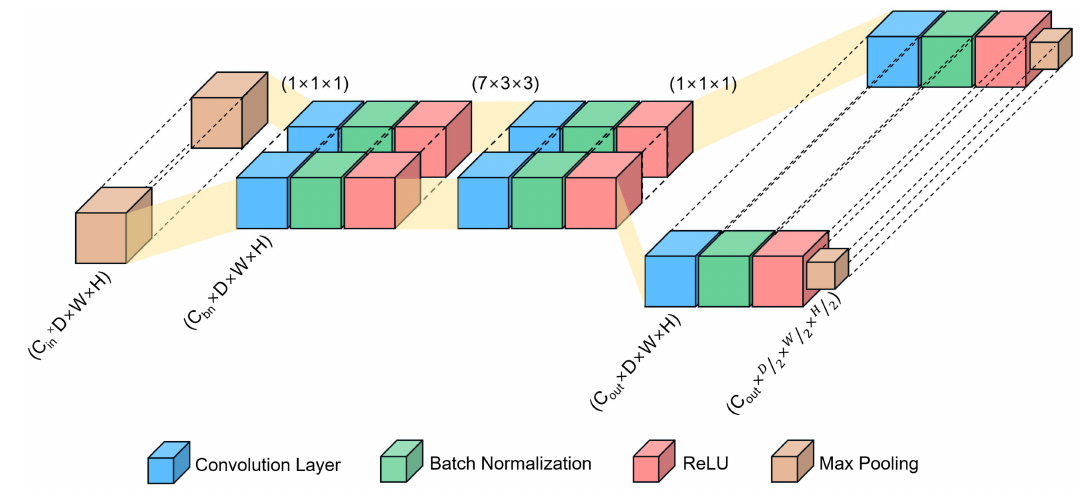
Figure 3. Illustration of a channel bottleneck block. C in , C bn , and C out represent the number of input channels, reduced channels, and output channels within the channel bottleneck block, respectively. D, W, and H denote the length, width, and height of the feature map, respectively. The first 1 × 1 × 1 convolution reduces the number of channels in the input data from the preceding layer. The 7 × 3 × 3 convolution is then computed on the reduced-channel layer. Finally, the last 1 × 1 × 1 convolution increases the number of channels in the output